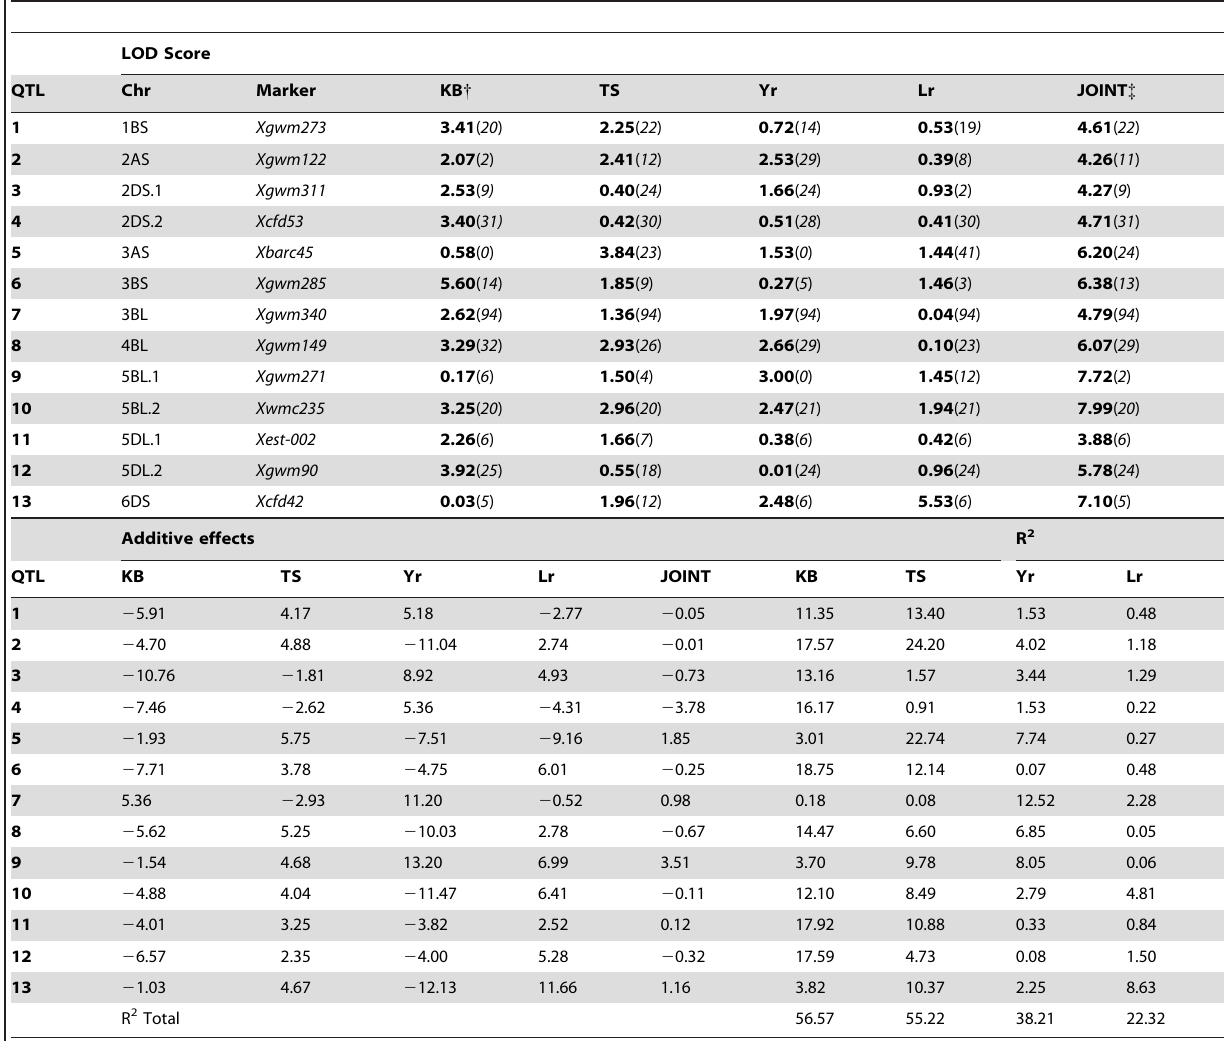
Table 3. First part: Significant QTLs, chromosome, nearest marker, LOD score values (outside brackets, in bold) and their positions (inside brackets, in italics) for multi trait analyses including traits Karnal bunt (KB), tan spot (TS), yellow rust (Yr) and leaf rust